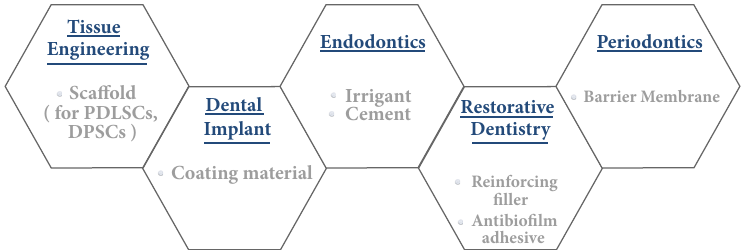
Figure 3: Currently, no studies correlating dentistry and GFNs have been done on human subjects. Based on the properties presented in in vivo and in vitro studies, the potential applications of GFNs thatcould be translate to clinical reality in dentistry were summarized by different dental